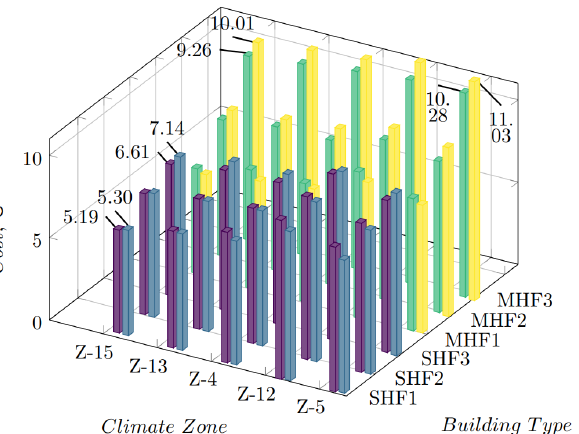
Figure 14. Cost comparison between full-load (left column, purple and green) and partial-load operation (right column, blue and yellow) for different climate zones and building types, for a WWB typical day (winter, working day,